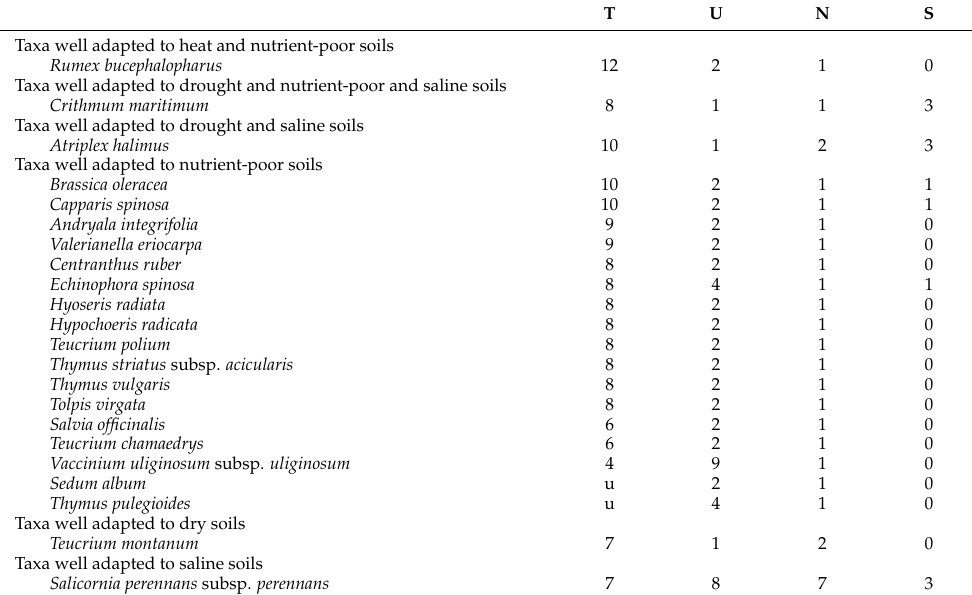
Table 2. Species showing the best adaptation to four major stress factors: T (temperature, range